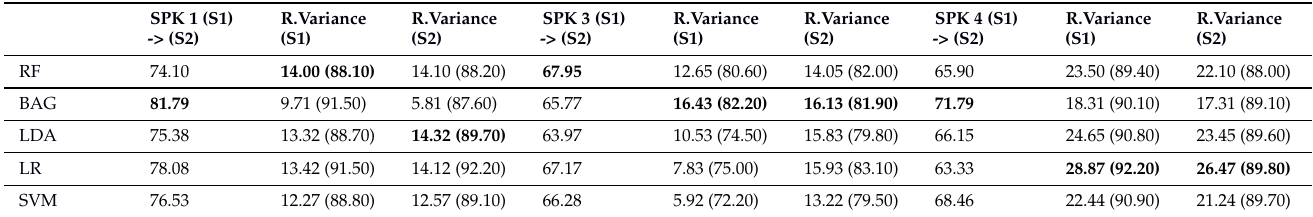
Table 4. Mean accuracy values, produced by all classifiers, for the Intra-Speaker experiment. Acquired data from the first session (session 1) was used for training, while data from the second session (session 2) was considered for testing. Relative variances between session-independent results and per-session results are also presented for each speaker. The highest values in each column are highlighted using bold